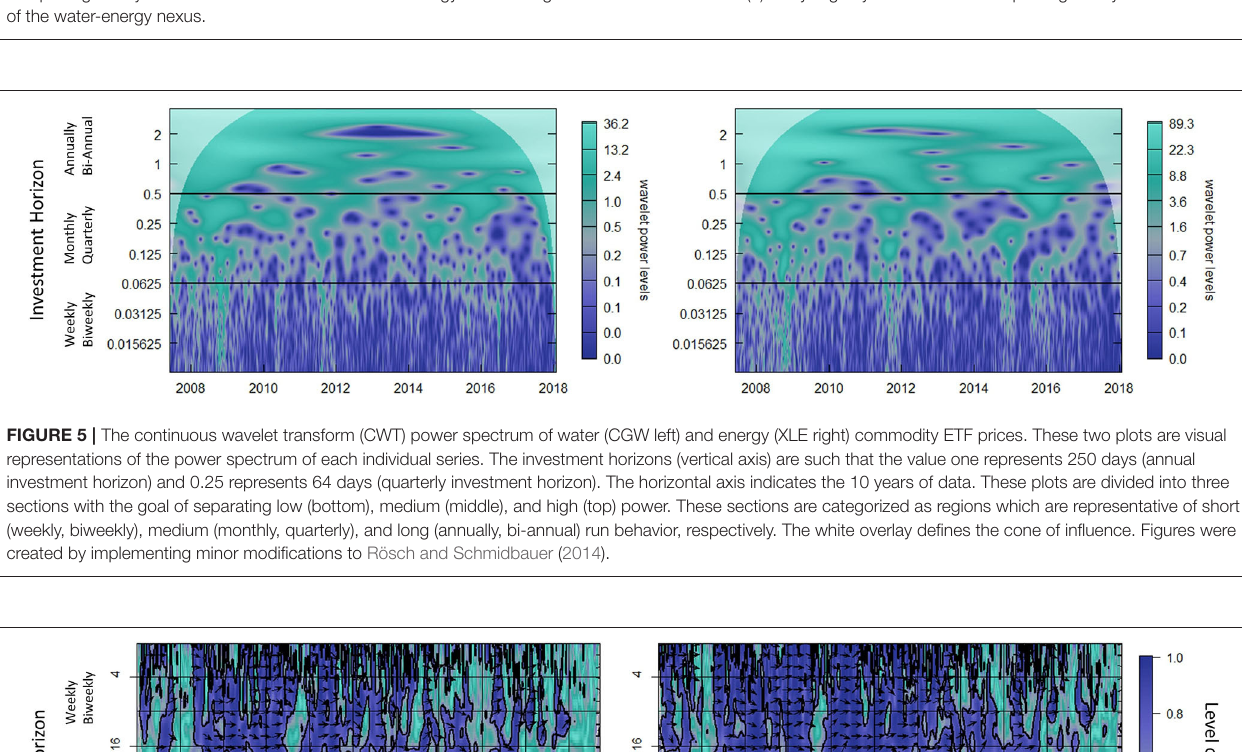
Frontiers in Energy Research |